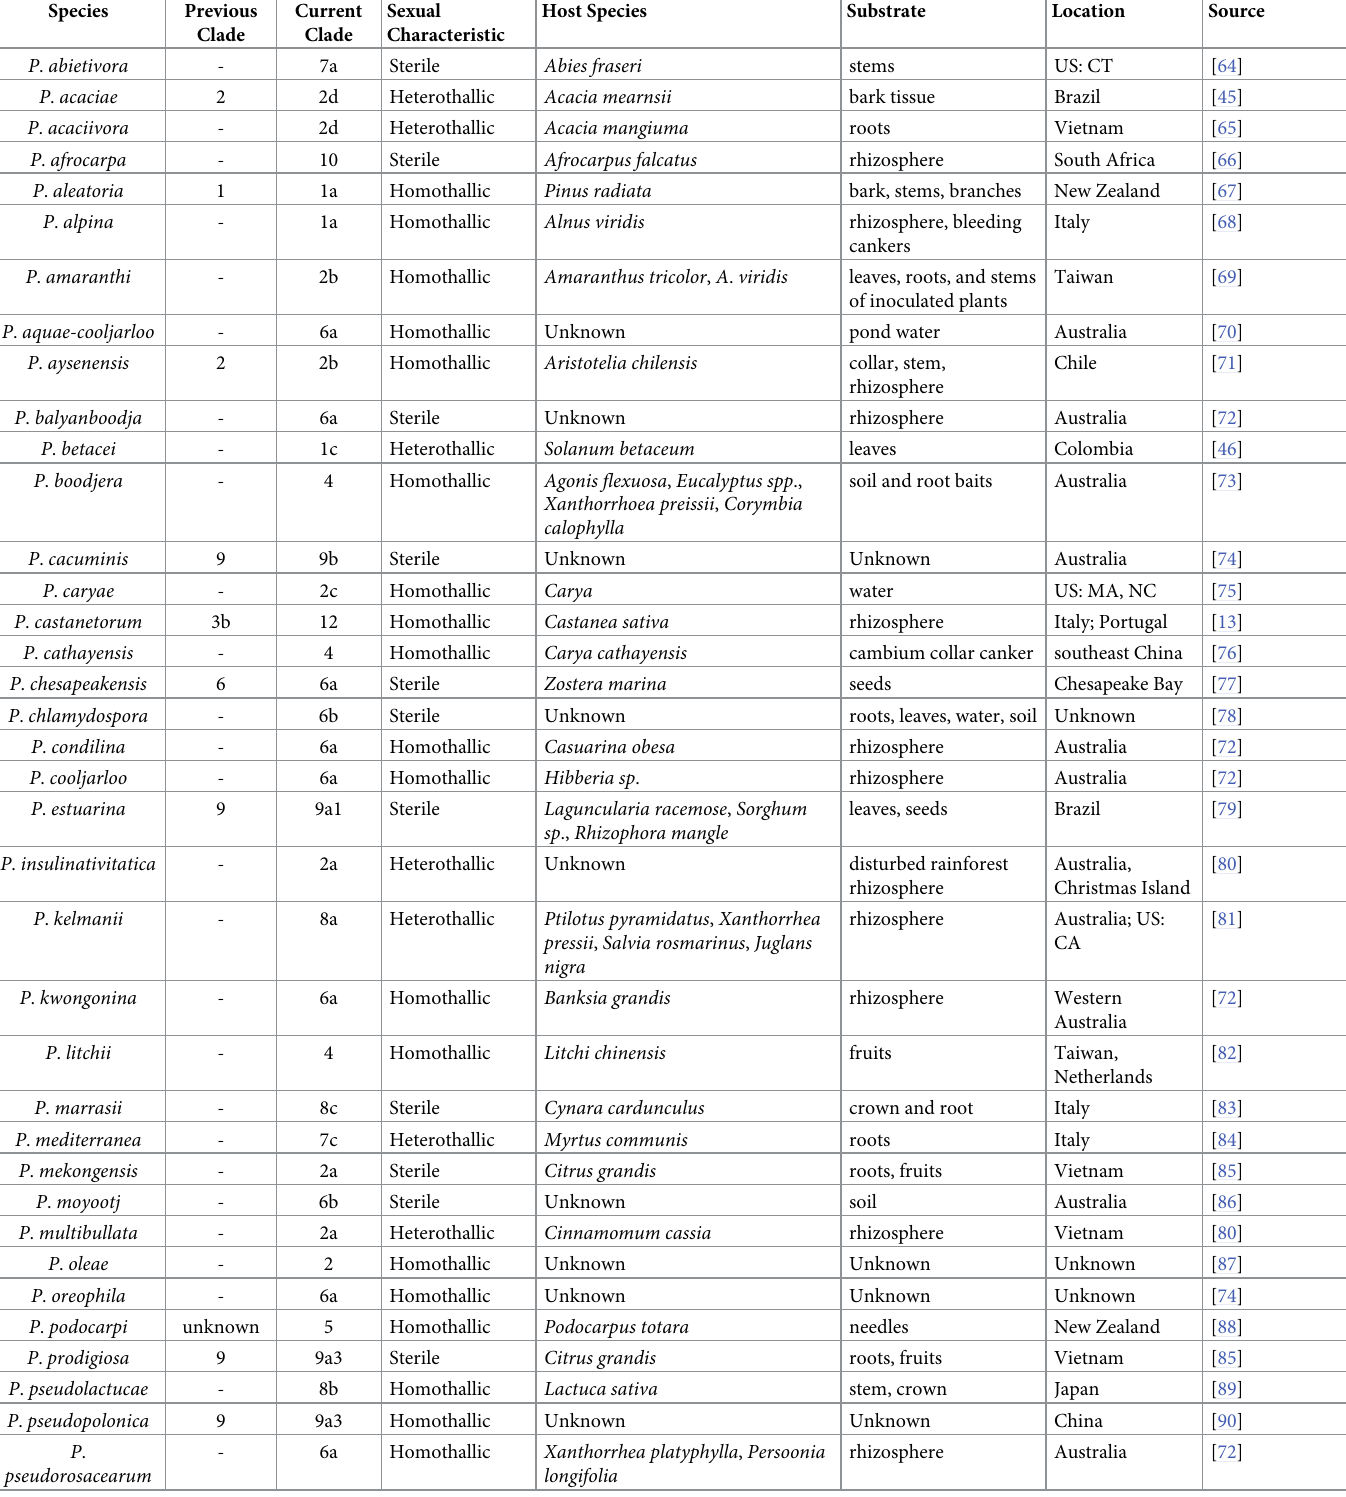
Table 1. Recently described Phytophthora taxa in TBAS phylogeny along with a summary of their associated metadata and species description paper.